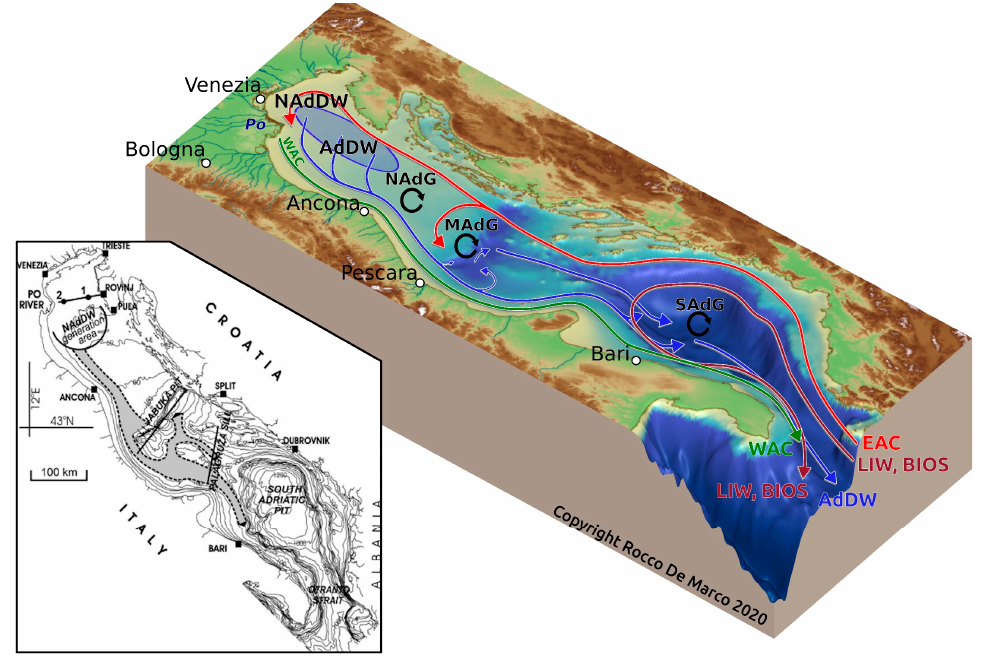
Figure 1. Bathymetric map of the Adriatic Sea with the three morphological sectors (lower left corner), the general Adriatic Sea circulation (in the center) and the study area (on the upper right corner). WAC: Western Adriatic Current; EAC: Eastern Adriatic Current; NAdG: North Adriatic Gyre; MAdG: Mid Adriatic Gyre; SAdG = South Adriatic Gyre. AdDW: Adriatic Dense Water (in blue North Adriatic formation area of AdW-NAdDW). LIW: Levantine intermediate Water. BIOS: Adriatic-Ionian bimodal oscillating system [50–53].